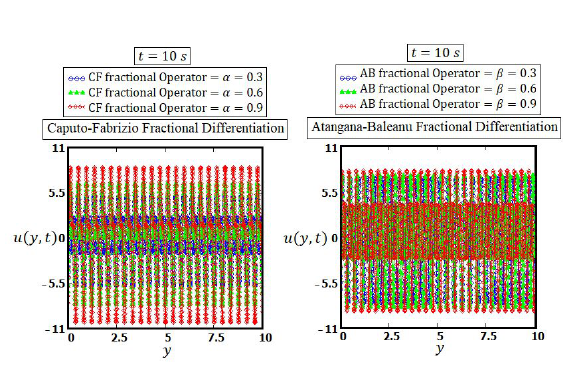
Figure 6: Graph of comparison of displacement via CF and AB frac- tional operator at larger time t = 10 s